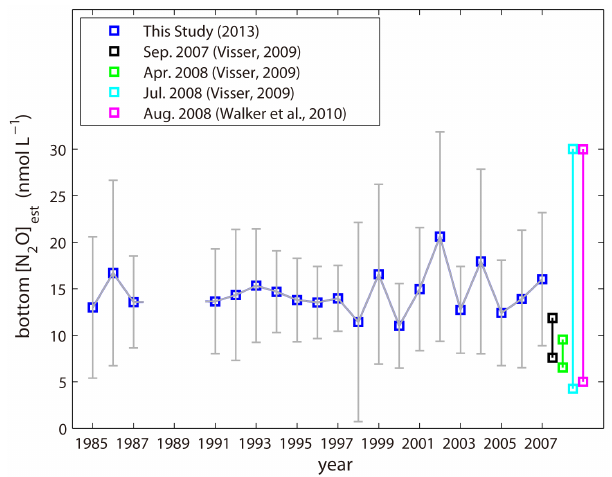
Fig. 2. Interannual variation of estimated bottom-water N 2 O con- centrations (blue square) in the nGOM during July 1985–2007. Measurements are included (black, green, cyan, and pink squares: September 2007, April 2008, July 2008, and August 2008, respec- tively).